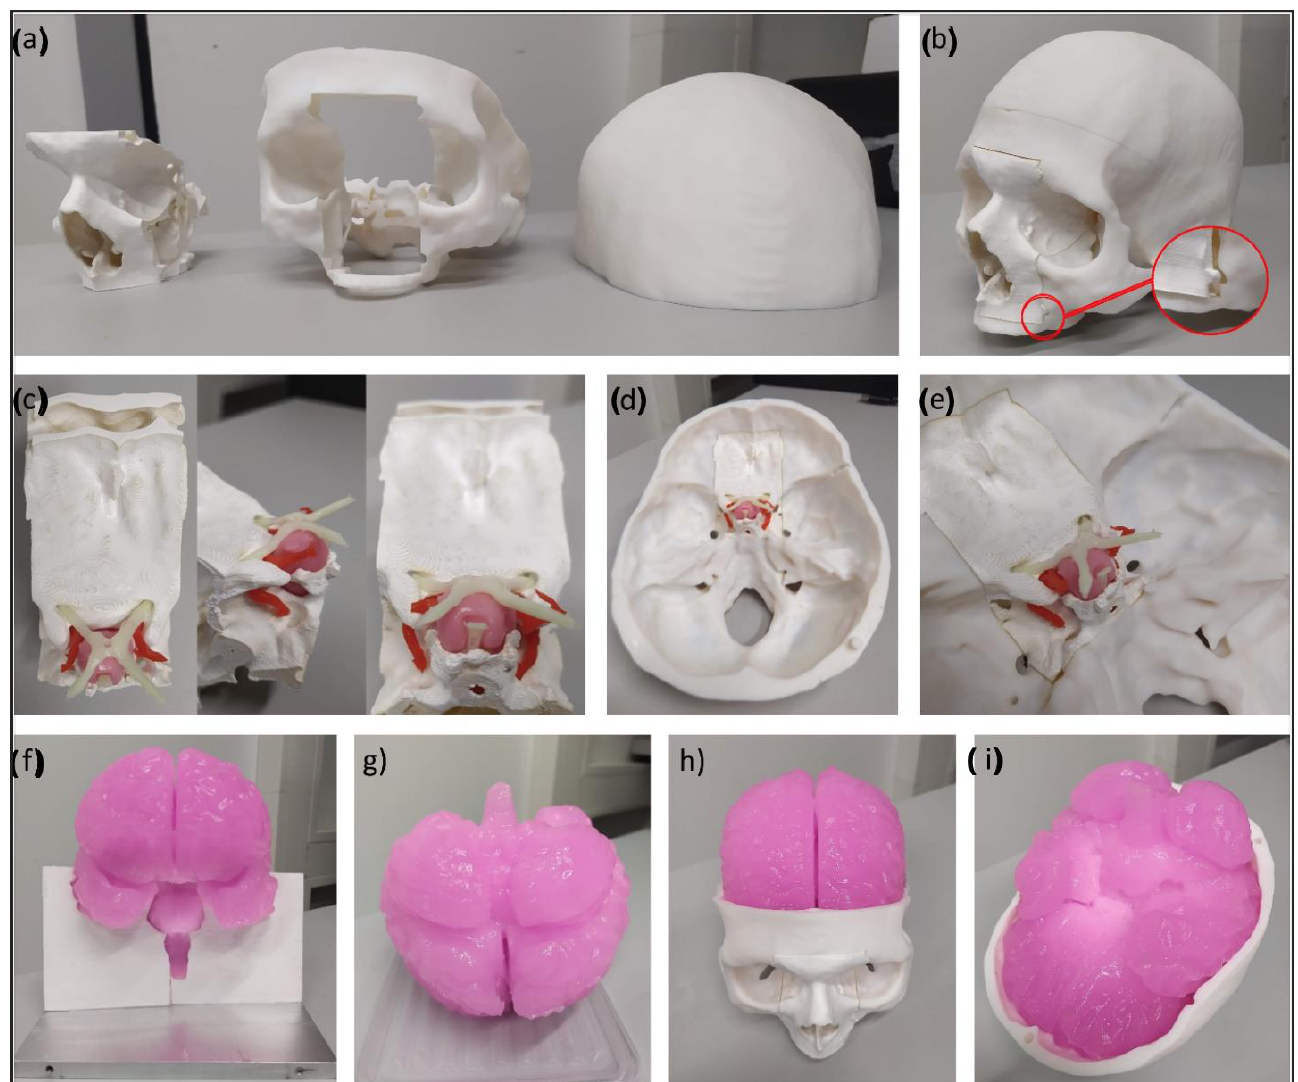
Figure 7. Final head phantom. ( a ) Skull phantom disassembled into its three parts. ( b ) Assembled skull and zoom-in view of the side groove of the maxilla that improves the fit of the nasal cavity insert into the skull phantom. ( c ) Upper and side views of the nasal cavity and skull-base inserts. ( d ) Back view of the nasal cavity inserted inside the skull. ( e ) Zoom-in of the nasal cavity inserted inside the skull. ( f ) Front view of the brain phantom, partially inside the mold. ( g ) Back view of the brain phantom. ( h ) Brain phantom placed inside the skull. ( i ) Brain phantom viewed from below, inserted inside the calvarium of the skull.